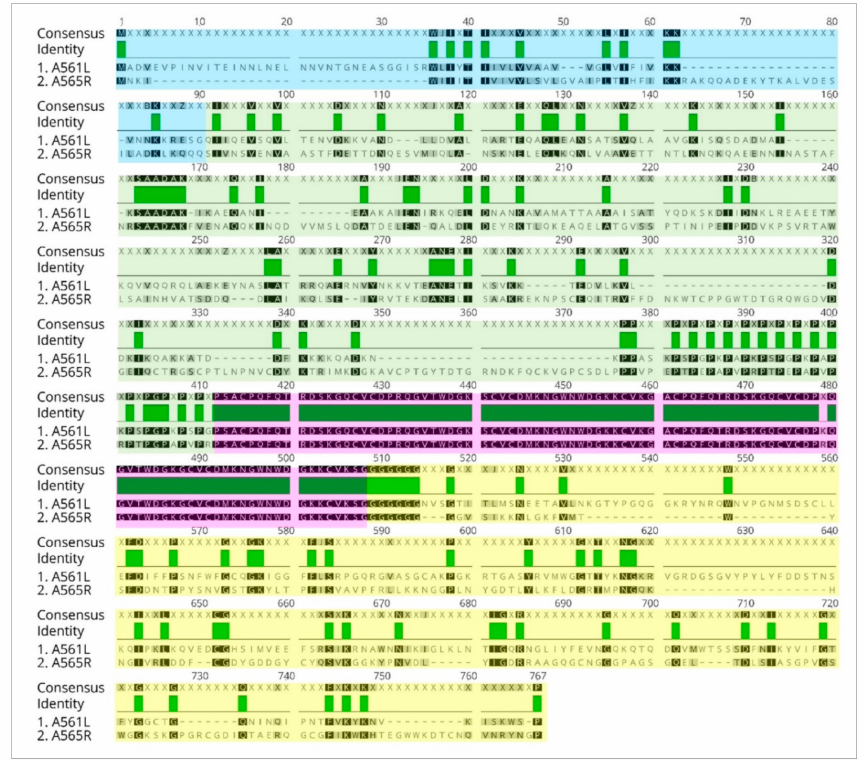
Figure A2. Pairwise amino acid alignment of A561L and A565R PBCV-1 proteins using Geneious 11.0.5 software. Green color denotes identical amino acids. Predicted domains in A561L: Domain 1 is highlighted in blue (69 aa); Domain 2 is highlighted in green (241 aa); Domain 3 is highlighted in pink (96 aa); and Domain 4 highlighted in yellow is an alginate lyase domain (242